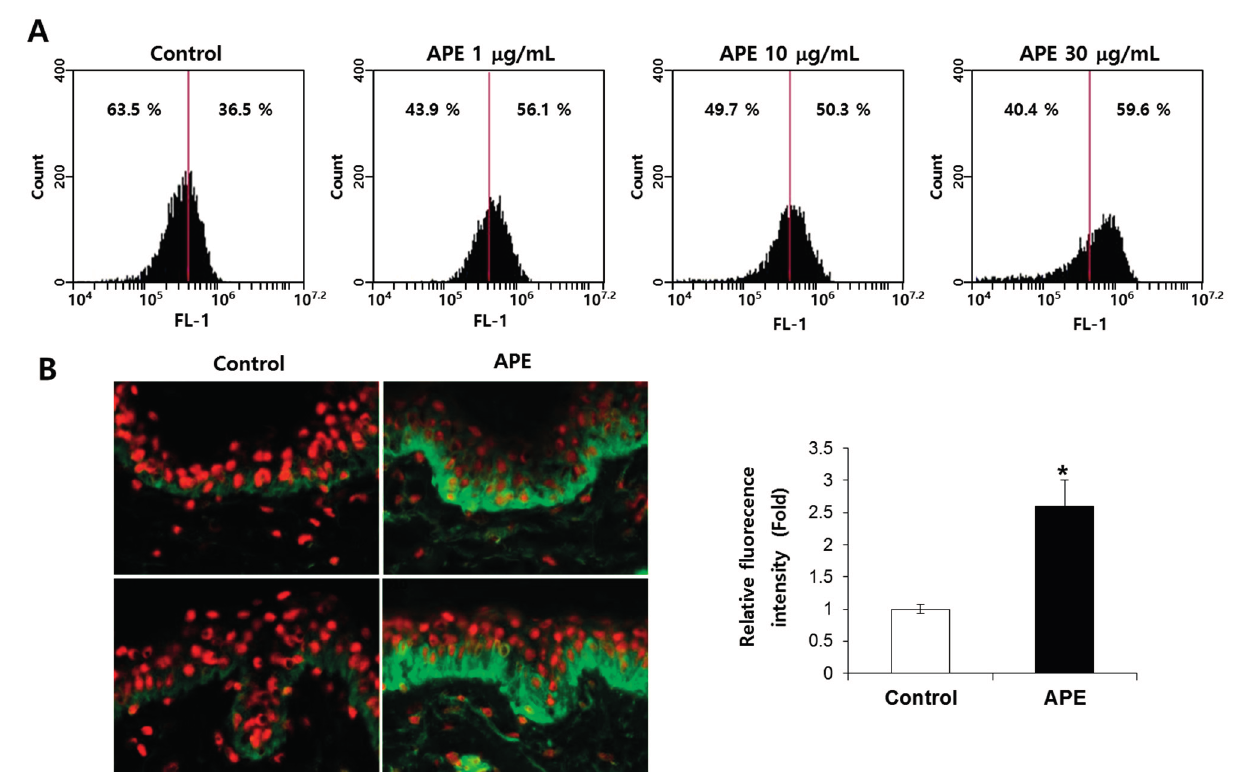
Figure 2. APE increased integrin β 1 expression in vitro and ex vivo . ( A ) A FACS analysis of the integrin β 1 expression in the EpSCs’ integrin β 1 antibody-conjugated cells shift to the right panel compared to the control. ( B ) The explants were kept in survival in a BEM culture medium for 10 days with the vehicle and 0.1% APE; integrin β 1 (CD29)